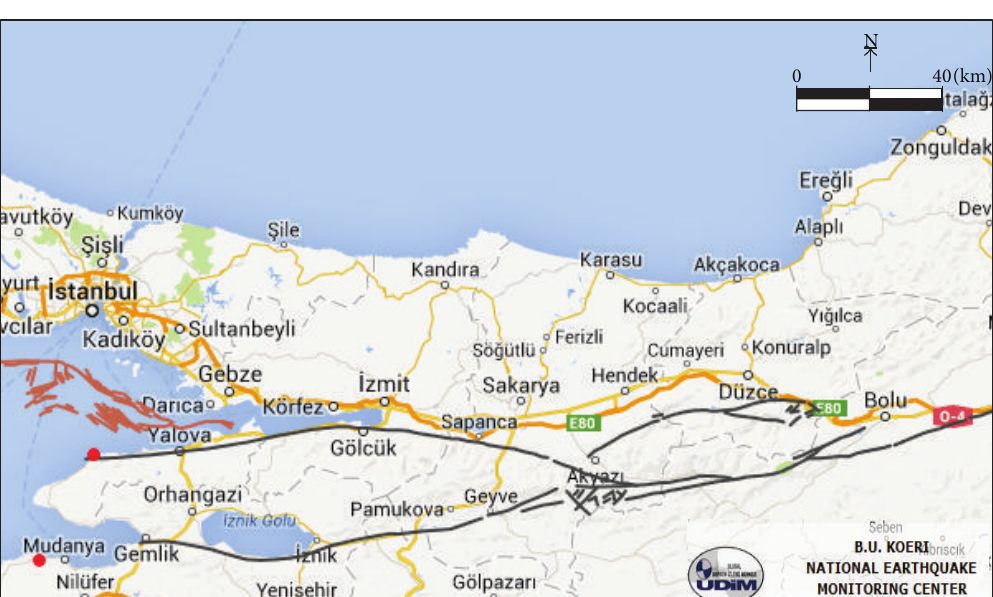
Figure 2: View of the Duzce fault